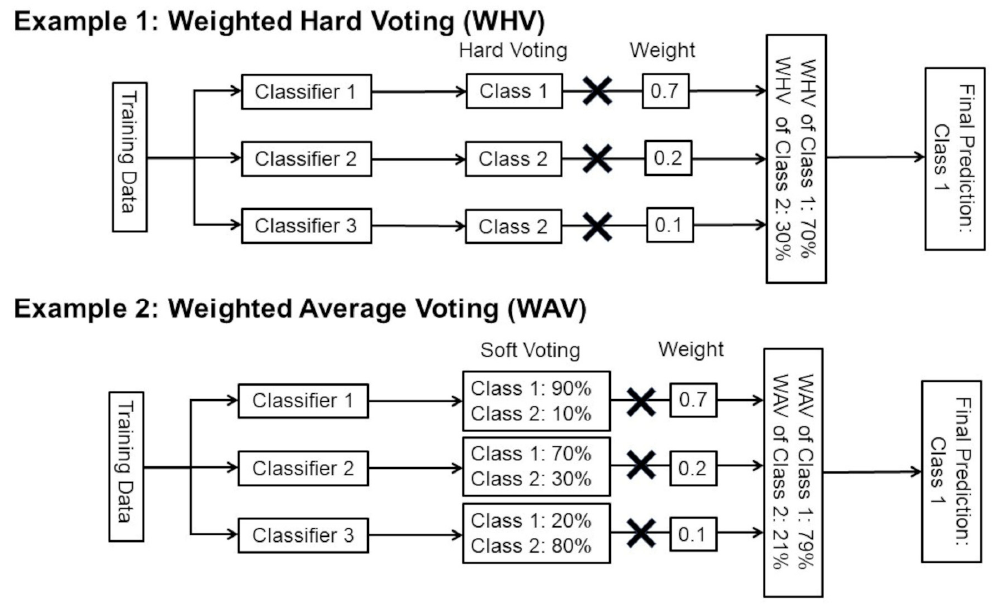
Figure 3. Examples of WHV and WAV. This figure shows examples of WHV and WAV with three different classifiers and two class classifications. In this study, 16 different classifiers and 4 class classifications were used.